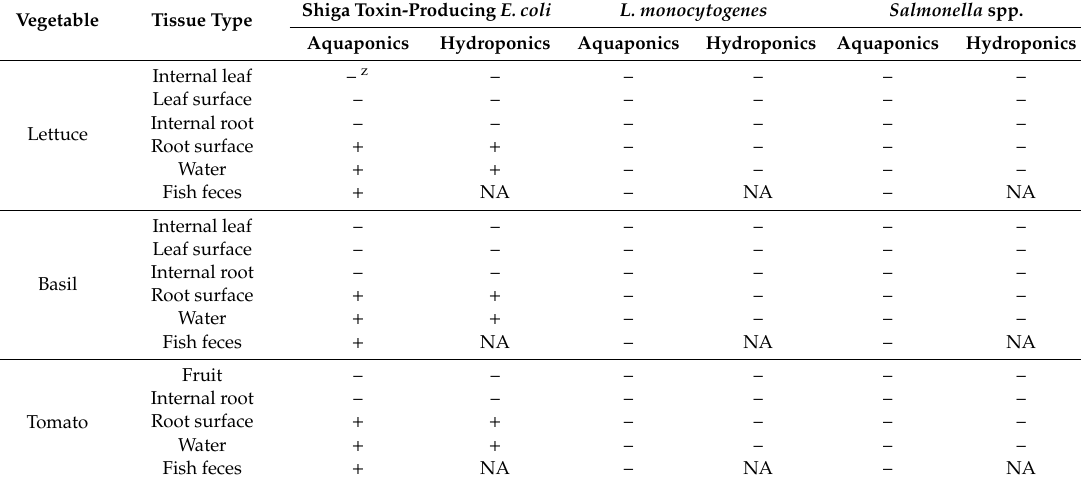
Table 3. Occurrence of STEC , L. monocytogenes , and Salmonella spp. in recirculating water and the roots and leaves, and / or fruit of lettuce and basil, and the roots, and fruit of tomato grown in aquaponic and hydroponic